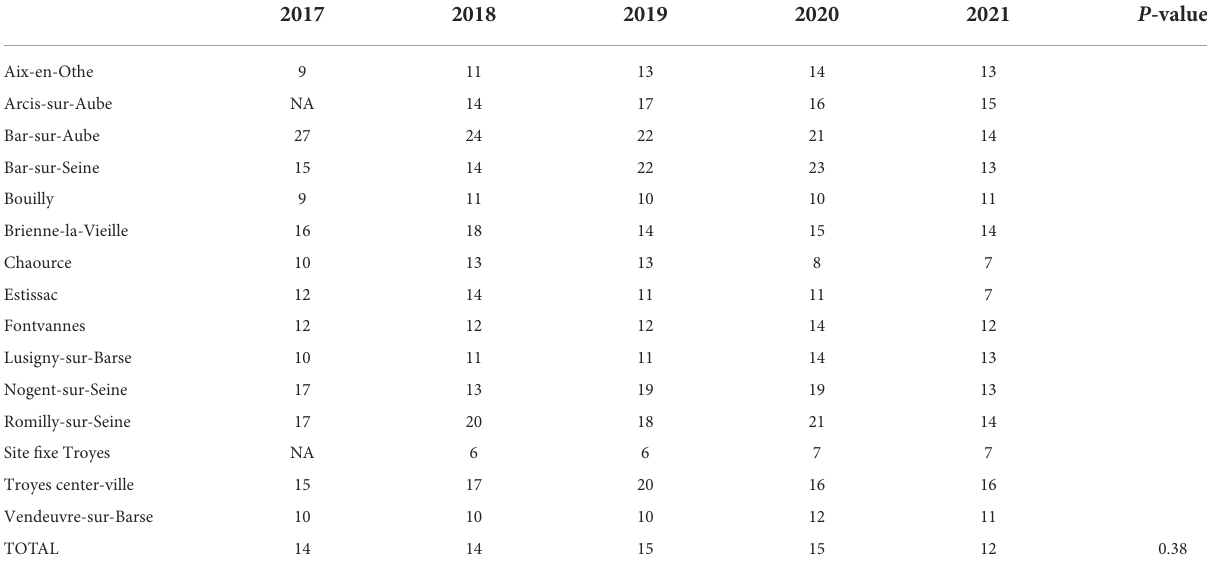
TABLE 2 Evolution of the number of donors per hour between 2017 and 2021.